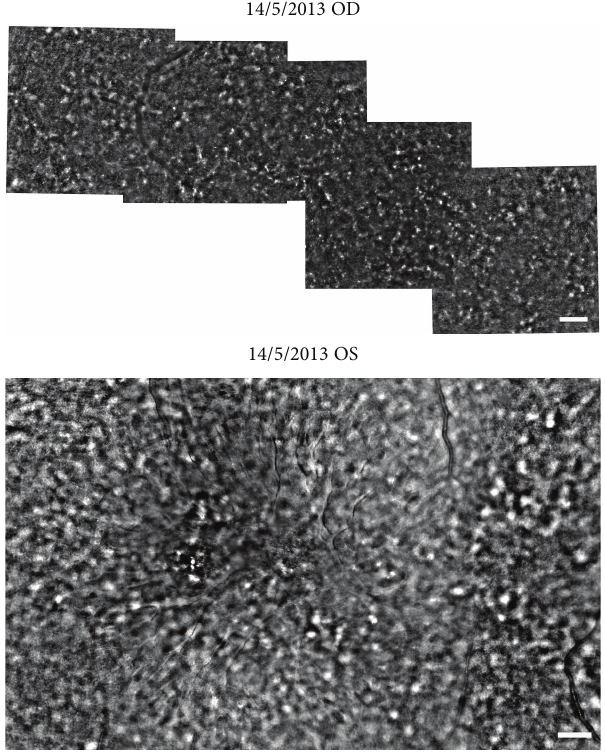
Figure 5: The baseline montage of AO images obtained from the macular region of the patient is shown. A montage of AO image of left eye shows spoke wheel pattern of the retinal folds in the inner retinal layer. The right eye does not show any folds. Bars 200 𝜇